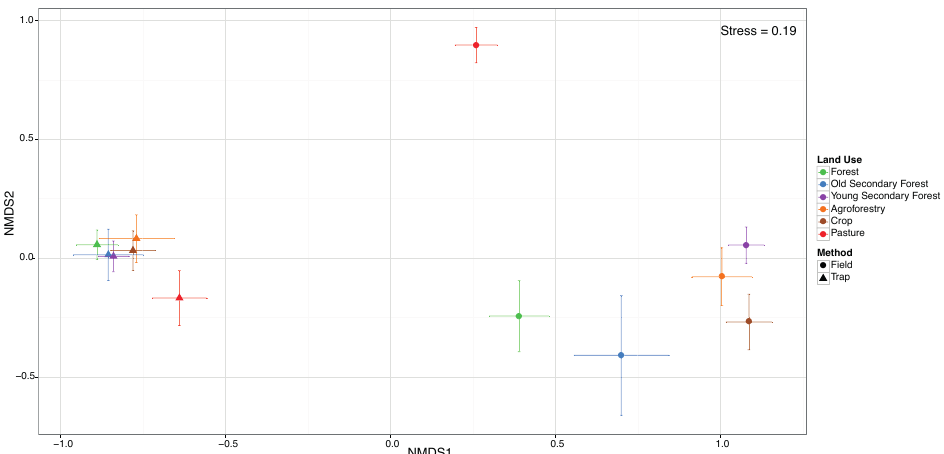
Figure 4 – Nonmetric multidimensional scaling of sampling points. Each point is the centroid of land use for each sample method, according to the legend at right. Bars indicate the standard error of the mean (n = 17 for Forest; n = 10 for Old Seconday Forest; n = 30 for Young secondary Forest; n = 10 for Agroforestry; n = 18 for Crop; n = 13 for